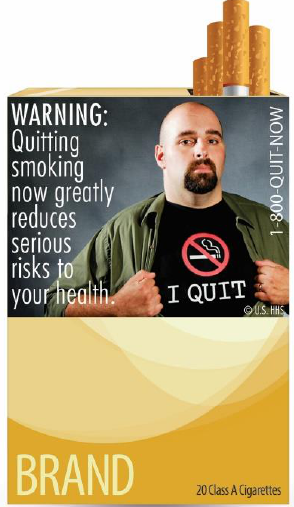
Figure 2. Example of the FDA’s proposed cigarette labels in 2011